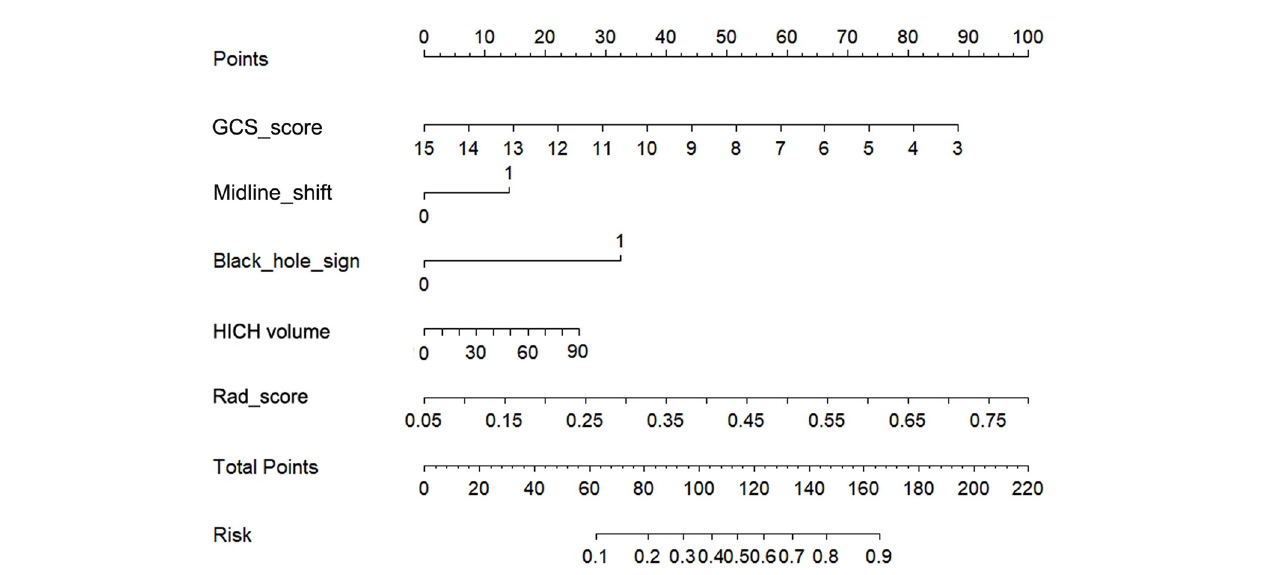
FIGURE4 The radiomics-clinical nomogram for assessing the 30-day clinical functional outcomes. Five variables, two points, and a risk estimation were incorporated into the nomogram. To use this nomogram, we added the points corresponding to each variable to get the total points and then find the corresponding risk estimation.